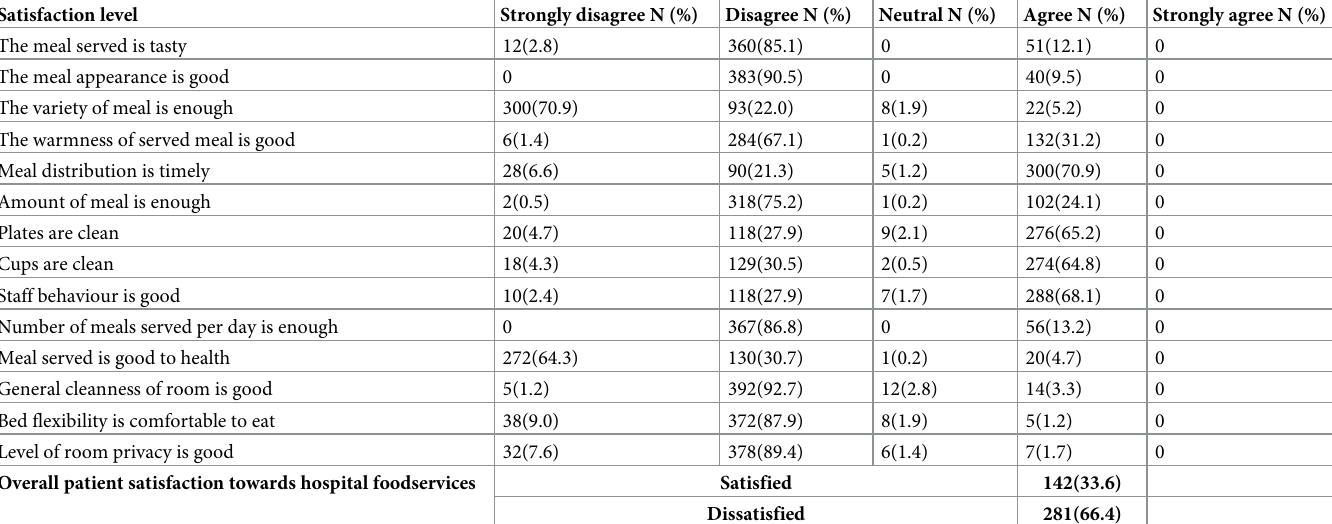
Table 2. Satisfaction level with hospital foodservices among adult patients,